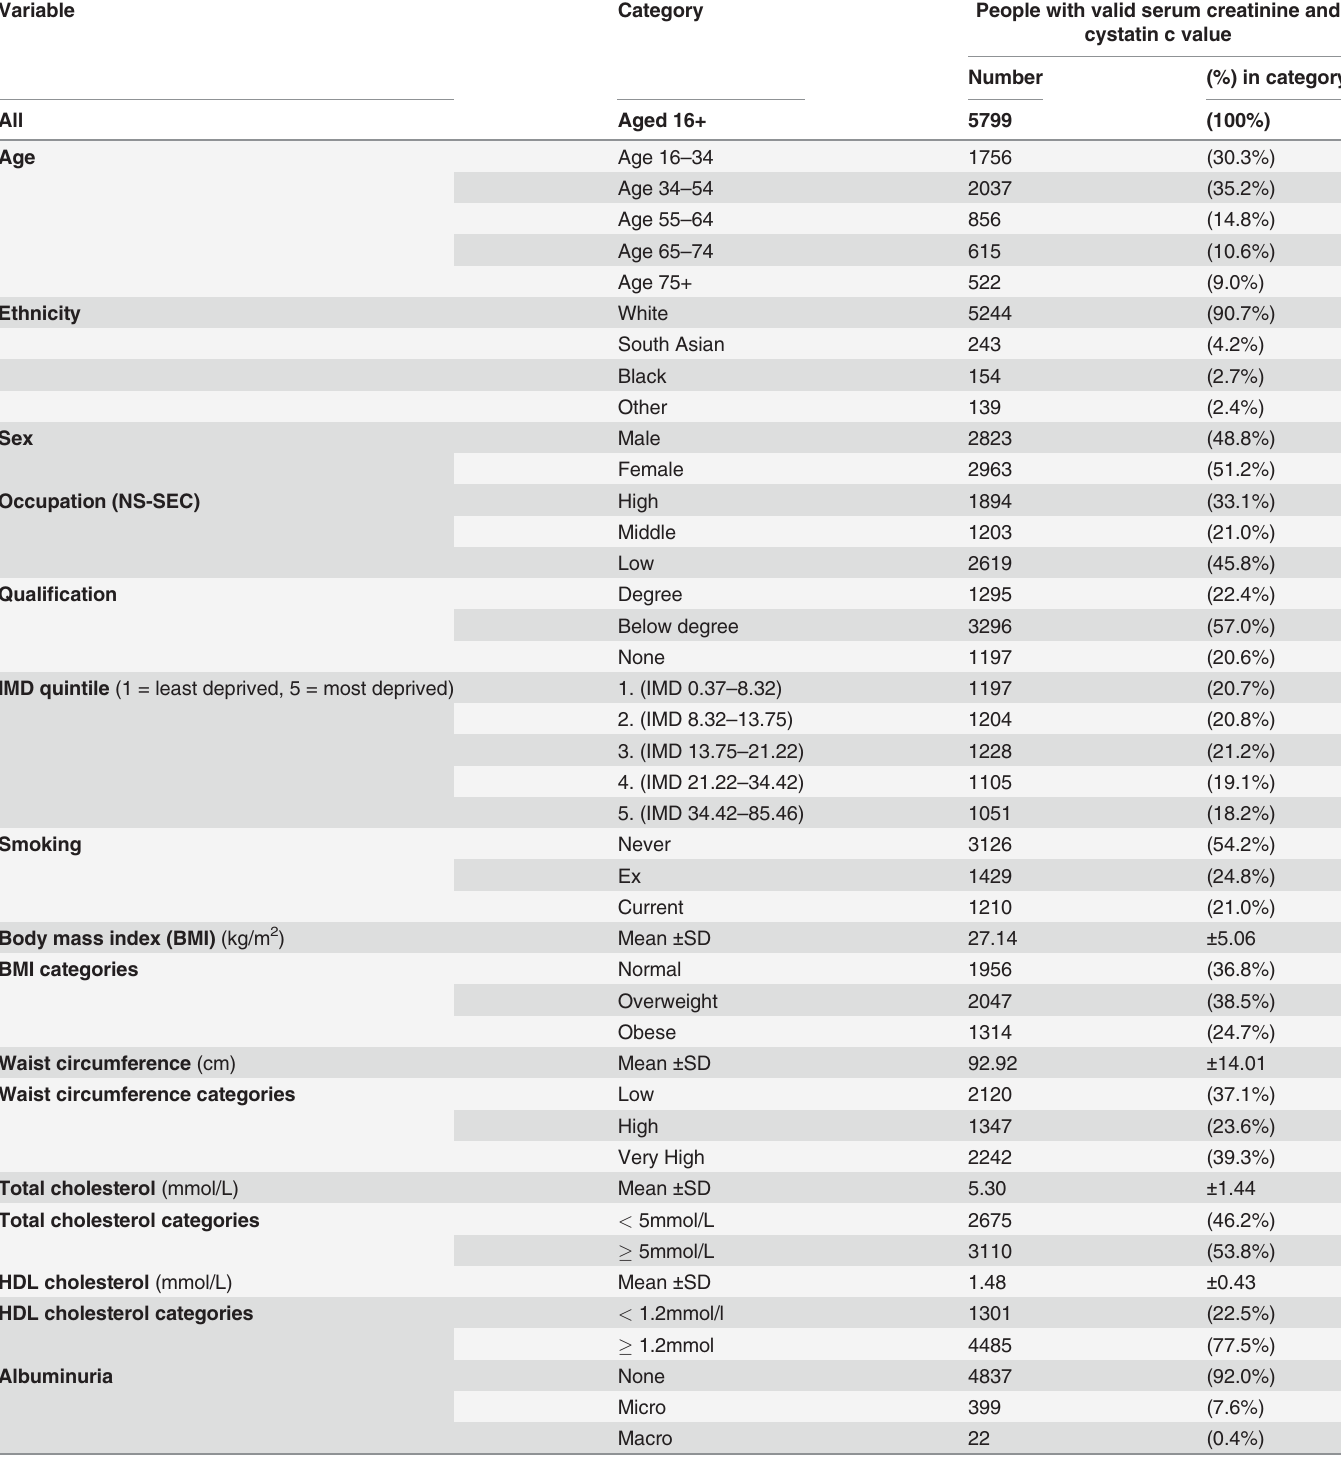
Table 1. Sociodemographic and clinical characteristics of the weighted study